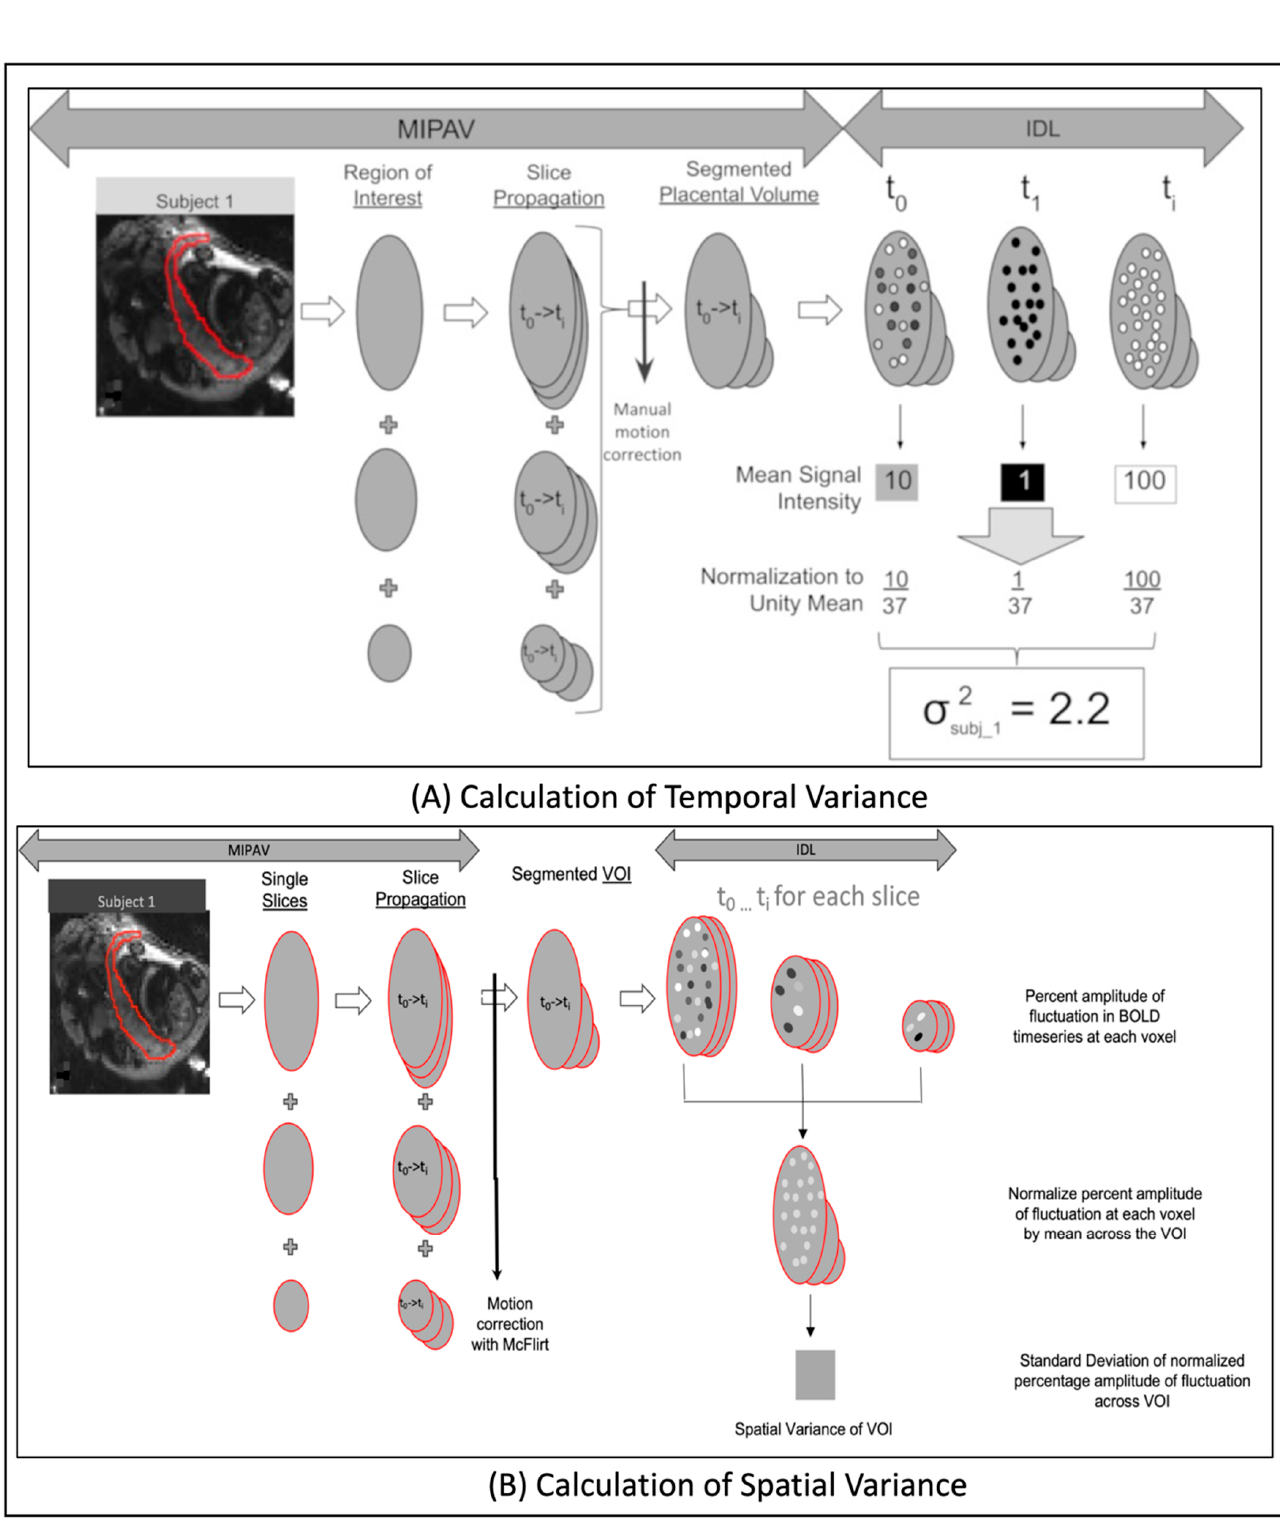
Figure 1. Pipeline for calculation of intrinsic spatial-temporal variance of placental and fetal brain BOLD signal: Schematics showing the computation of: ( A ) temporal variance (TV) and; ( B ) spatial variance (SV) of intrinsic BOLD signal in the whole placental structure. A similar method was used to compute these metrics in the whole fetal brain structure.